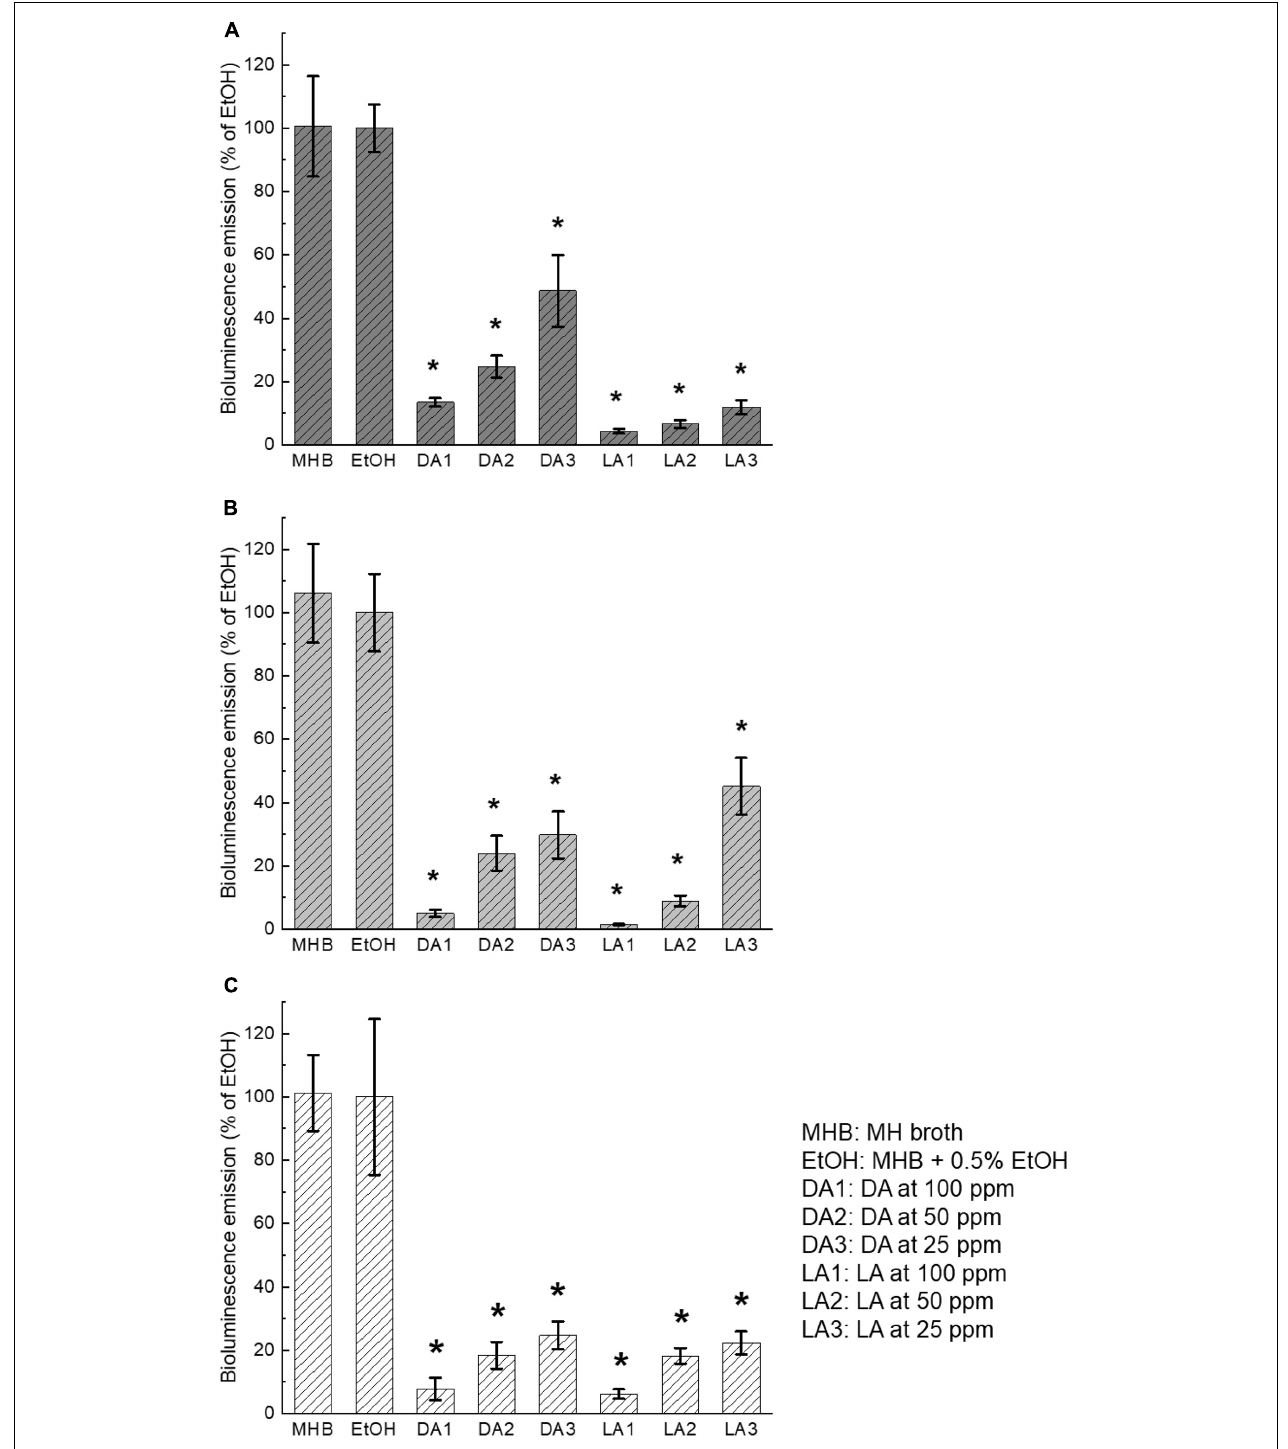
FIGURE 2 | Inhibition of C. jejuni AI-2 activity by decanoic acid (DA) and lauric acid (LA). C. jejuni strain F38011 (A) , NCTC11168 (B) , ATCC33560 (C) . Bioluminescence emission of V. harveyi BB170 with the addition of cell-free supernatants collected from the supernatant of C. jejuni biofilm incubated with or without fatty acids for 72 h at 37 ◦ C under microaerobic condition was separately determined. MH broth containing 0.5% ethanol was used as ethanol control. MHB is the broth control and EtOH is the negative control. Bioluminescence level of the negative control was set at 100%. Bioluminescence emission of each treatment was normalized to the control. Three biological replicates were performed. * Statistical significance between negative control and treated samples was determined by one-way ANOVA coupled with Dunnett’s multiple comparisons test ( P < 0.05 was considered statistically significant).